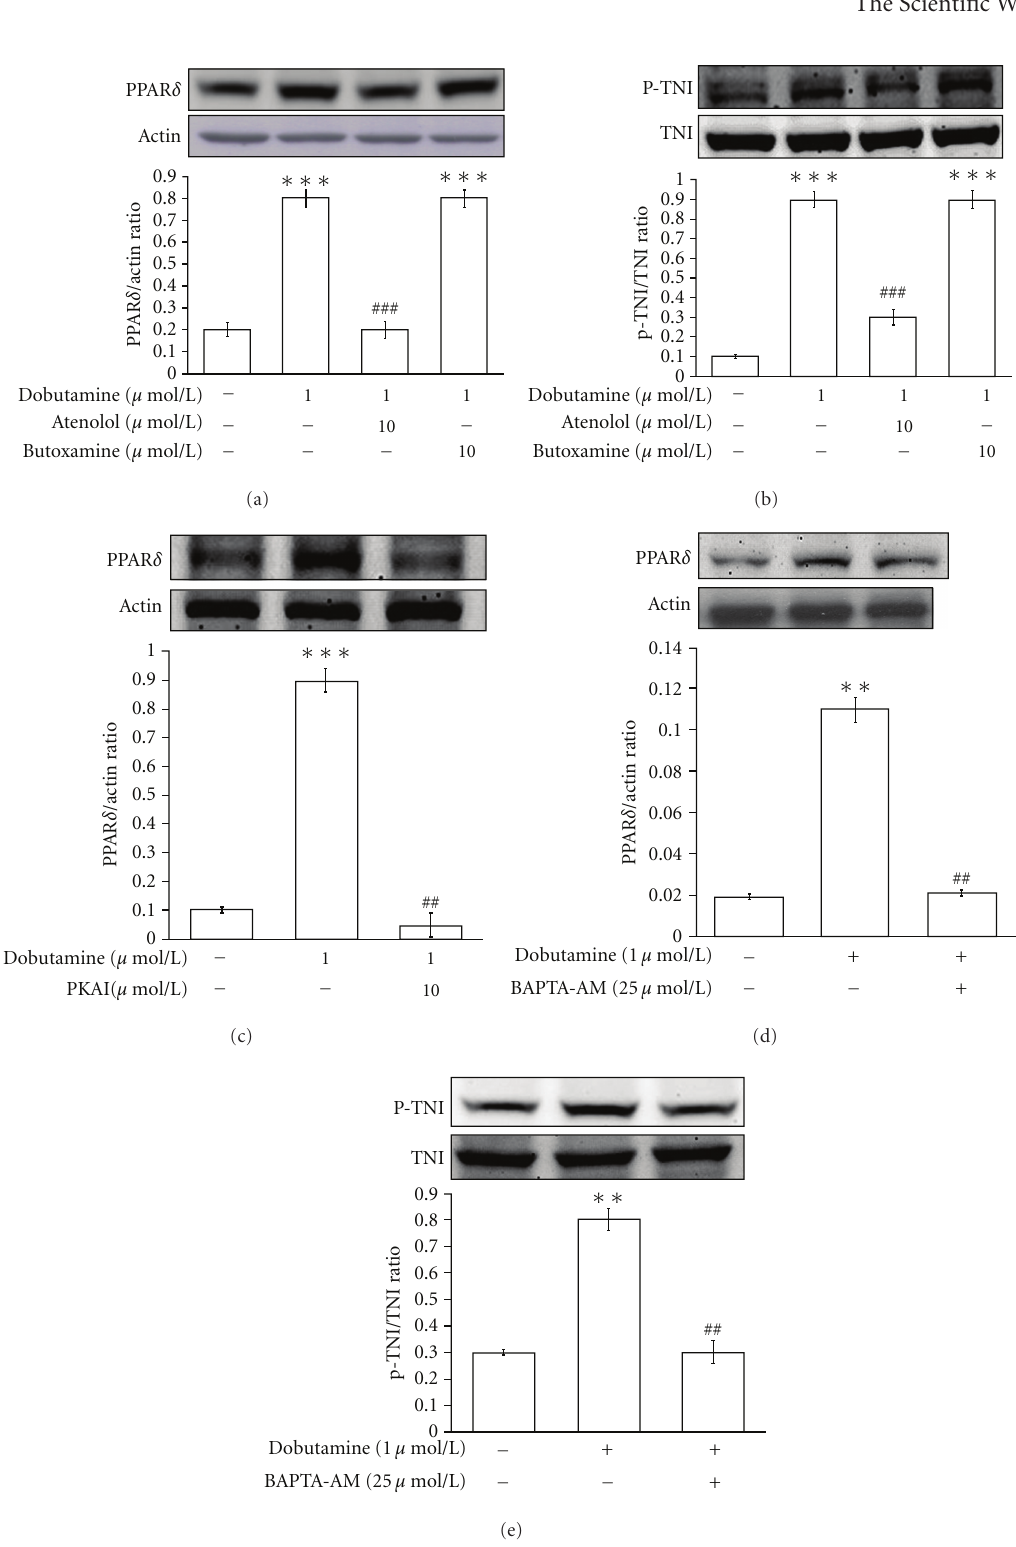
Figure 2: E ff ects of receptor antagonists, protein kinase A inhibitor, and calcium chelater on dobutamine-induced actions in neonatal rat cardiomyocytes . The neonatal rat cardiomyocytes were treated with atenolol, butoxamine, PKAI or BAPTA-AM at indicated concentration for 30minutes prior to incubation with 1 μ mol/L dobutamine. All drugs were dissolved in normal medium. Cells treated with the same volume of normal medium only are indicated as the vehicle-treated control. The treated cells were then harvested to measure PPAR δ protein expression (a, c, d) and cTnI phosphorylation (b, e) using Western blotting analysis. All values are expressed as mean ± SEM ( n = 6 per group). ∗ P < 0 . 05 as compared with the vehicle-treated control. # P < 0 . 05 as compared to cells treated with dobutamine